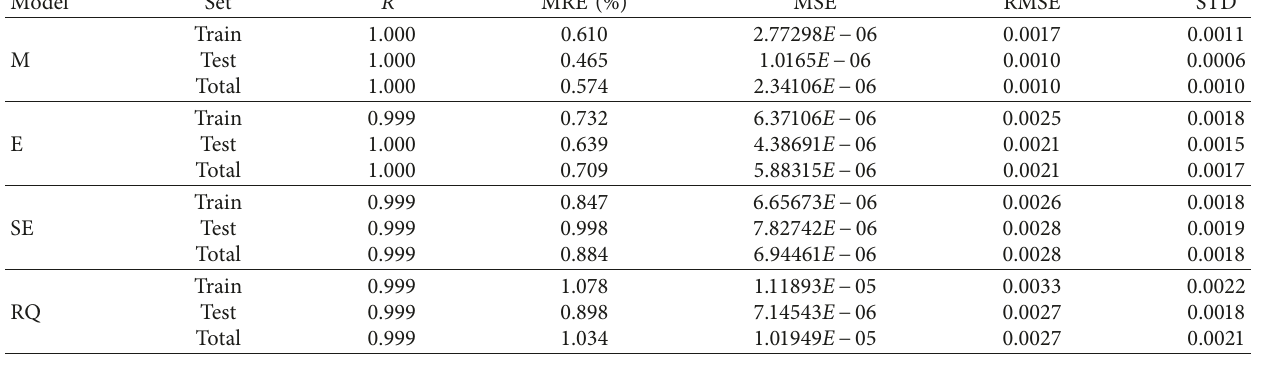
Table 1: Determining statistical parameters in different phases for models (a) M, (b) E, (c) SE, and (d) RQ. Model